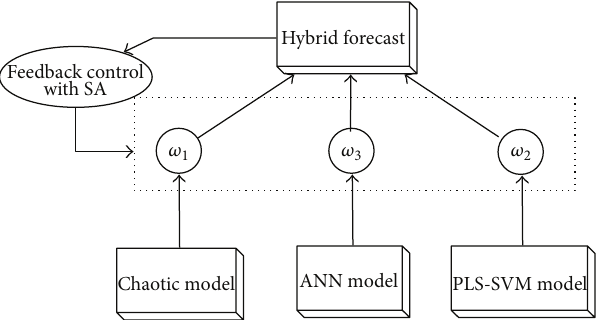
Figure 1: Structure of the hybrid model. The weights are decided by feedback in the SA process to optimize the best forecast of a time